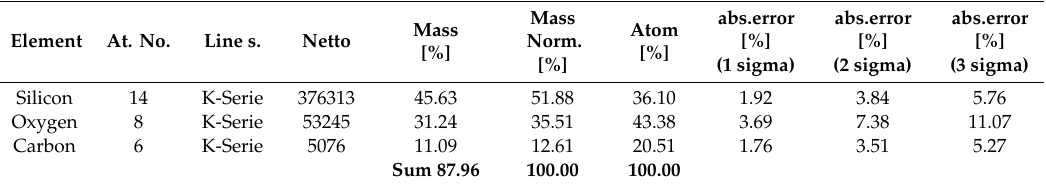
Figure 9. Chemical composition by EDS of the silica nanoparticles. Table 3. Elemental analysis of the SiO 2